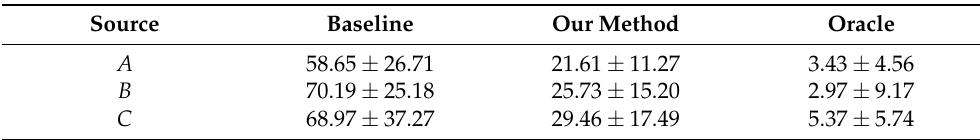
Table 4. Results on domain generalization of our approach in rMAE (%). We show the results of the generalized dataset training with just one source dataset in each column. The final row depicts the performance of a fully supervised model with access to all